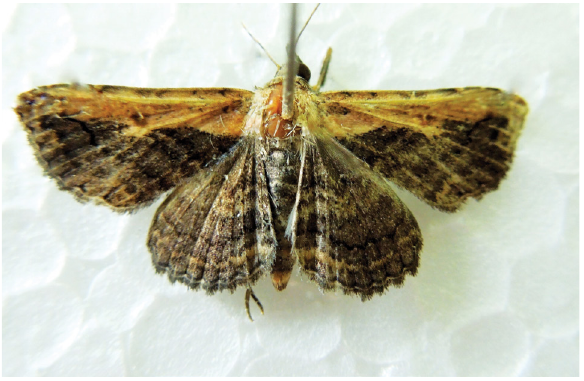
Figure 3. Adult of Selenisa sueroides (Guenée, 1852) (Lepidoptera: Noctuidae).